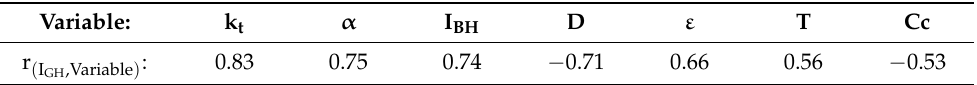
Table 2. The Pearson correlation coefficient r ( I GH ,variable ) for detecting redundant information.